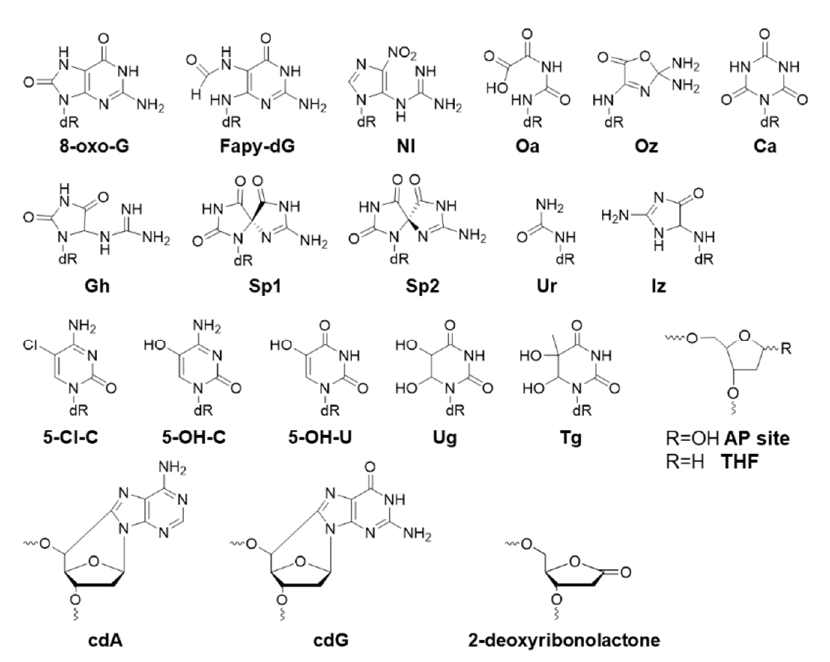
Figure 2. Structures of oxidative lesions.